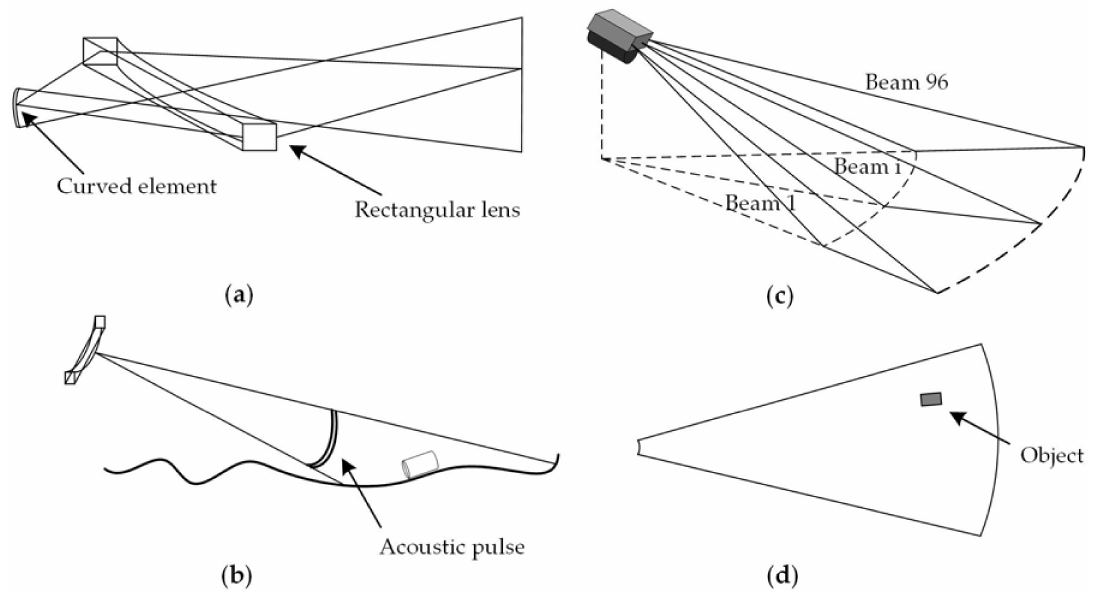
Figure 1. Diagrams of the sonar imaging. ( a ) A line-focus lens system is composed of a rectangular lens and a curved element; ( b ) one beam ensonifies a stripe along the bottom; ( c ) a total of 96 beams are working together; ( d ) an acoustic image acquired from the adaptive resolution imaging sonar